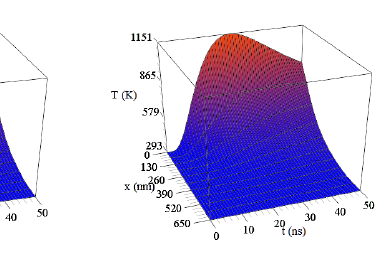
Figure 6. Temperature profile T ( x , t ) for F 0 = 50 mJ / cm 2 .